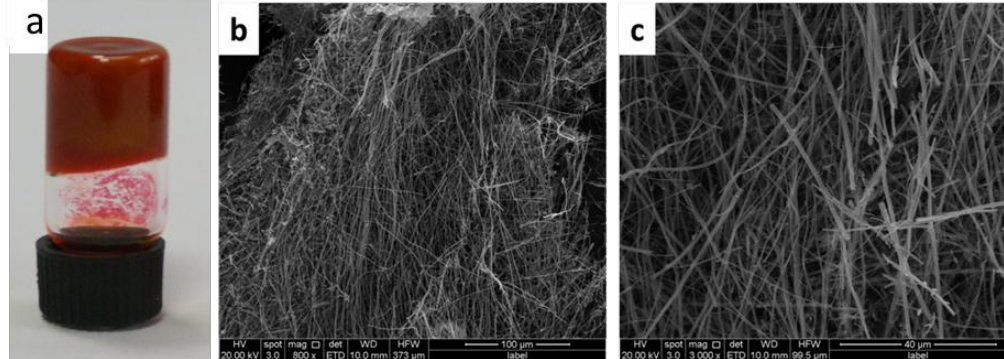
Figure 1. ( a ) Photo of the gel; scanning electron microscope (SEM) images of the samples ( b ) for NAPD/MM/RF ([NAPD] = 5 g/L) in larger scale; ( c ) for NAPD/MM/RF in small scale.